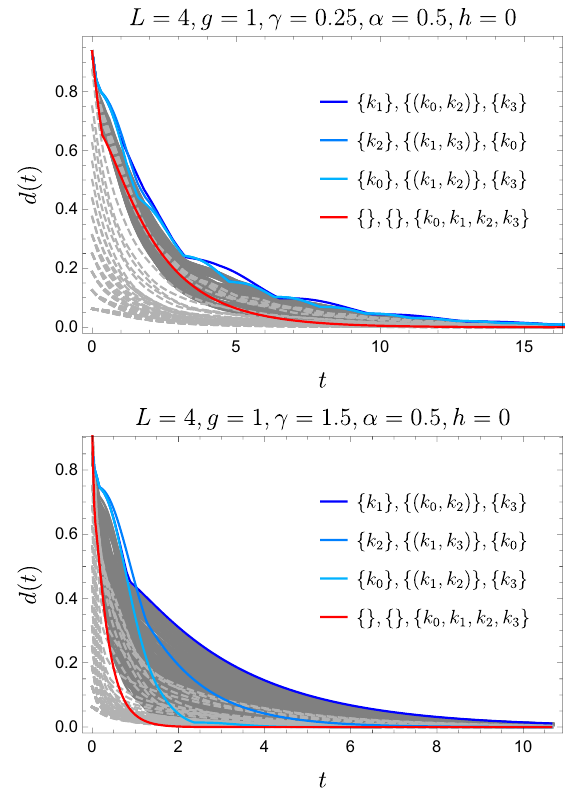
Figure 6: Evolution of the distance to equilibrium in the topological model for L = 4 and various choices of parameters. The dashed light gray lines correspond to random initial density matrices with various levels of mixing, while the darker gray lines correspond to initial pure quantum states. The colored lines are analytical predictions for initial density matrices of the type (46), where we recall the notation k